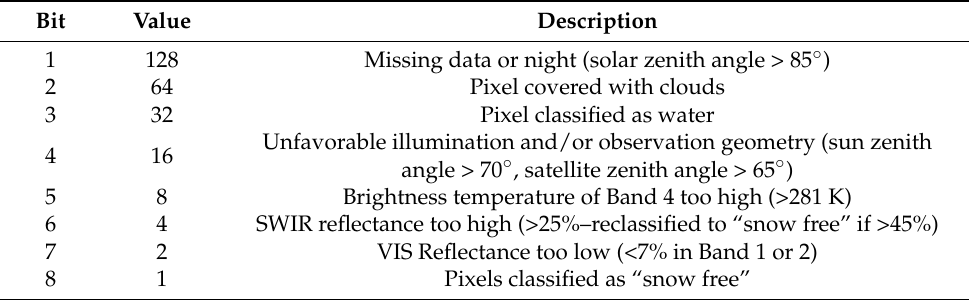
Table 1. Description of the bits in the layer